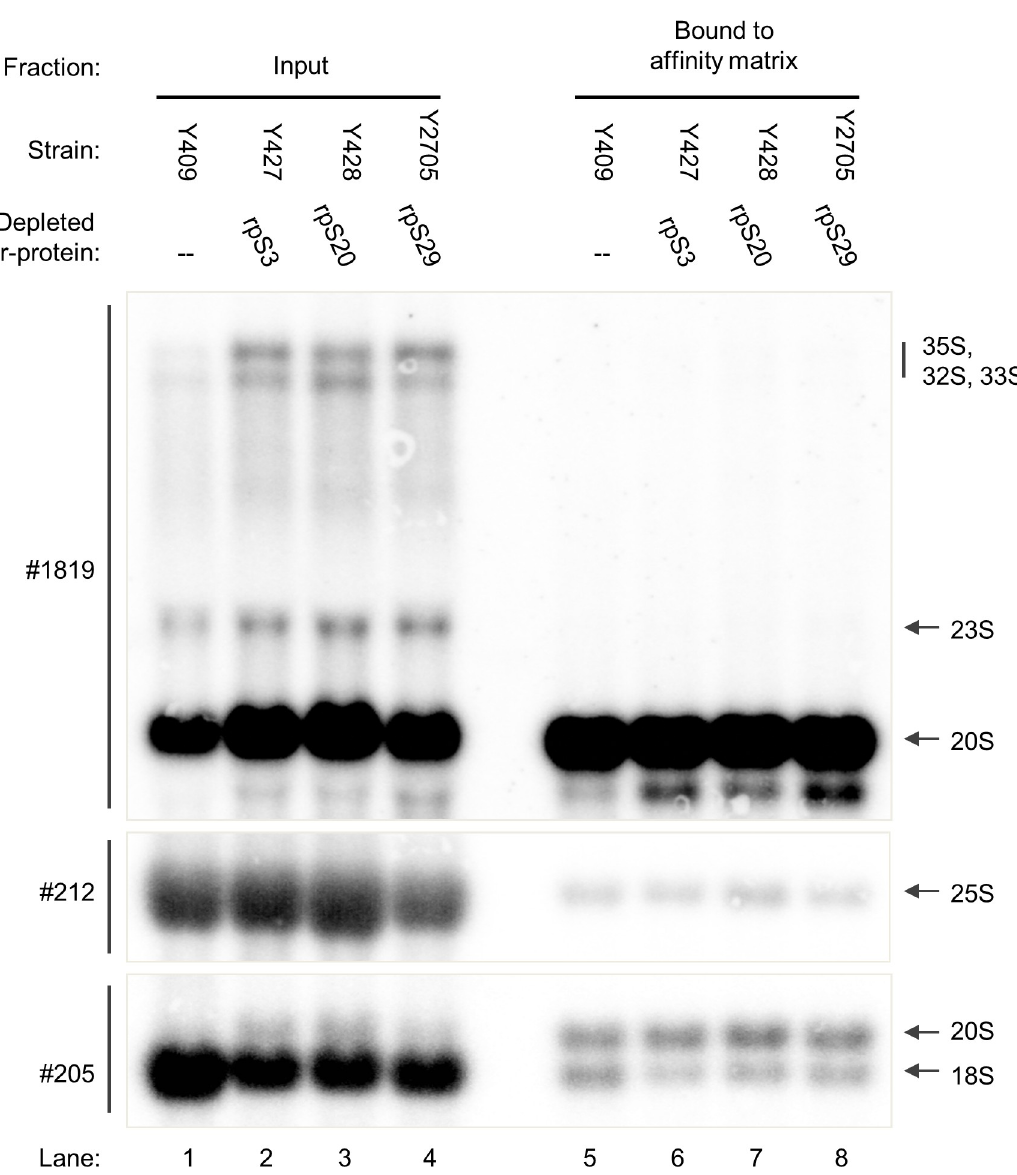
Fig 2. Association of Rio2 with SSU precursors depleted of S3-cluster proteins. The indicated yeast strains were cultivated for four hours in glucose containing medium to shut down expression of either rpS3, rpS20, rpS29 or no r-protein. 0.53% of each of the input fractions and 26% of each of the purified fractions was analysed, equal signal intensities for respective pairs of input and purified fractions indicate approximately 2% purification efficiency. Otherwise, see legend to Fig 1.